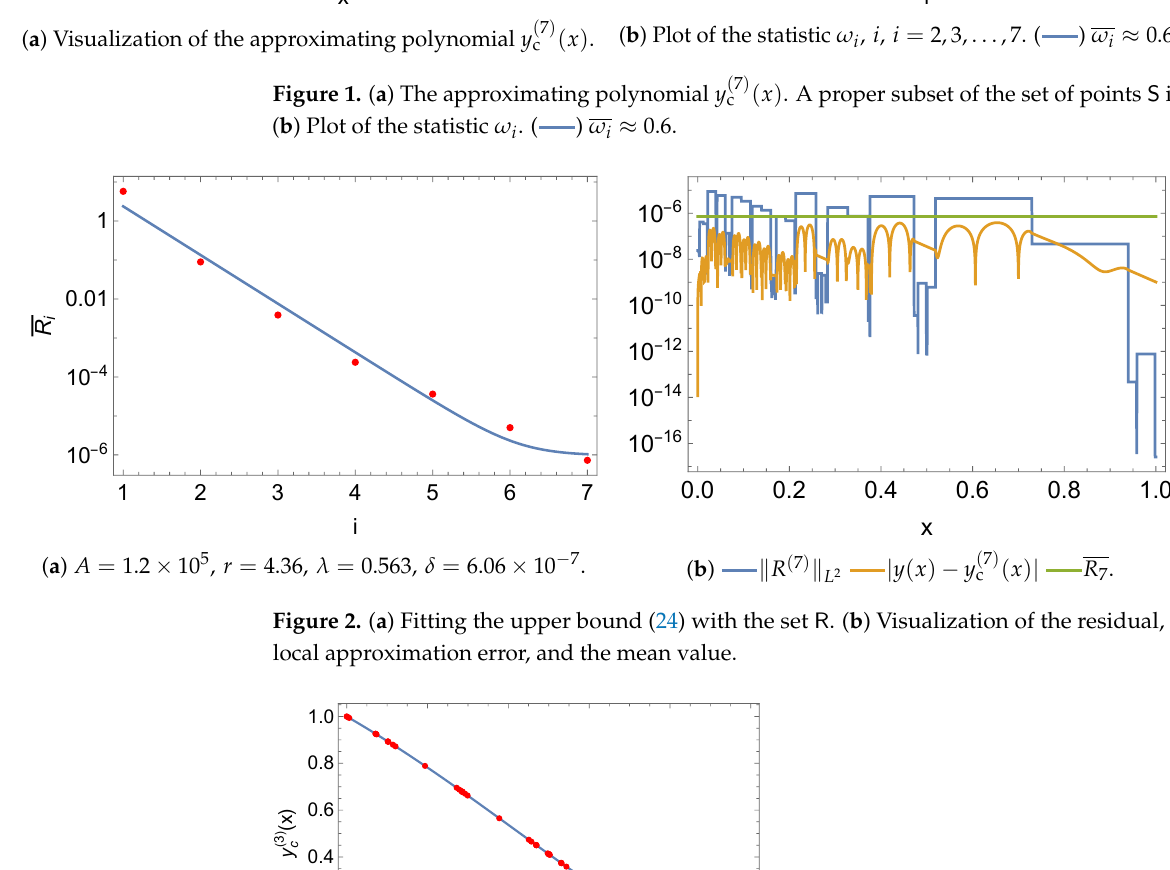
Figure 3. The approximating polynomial y